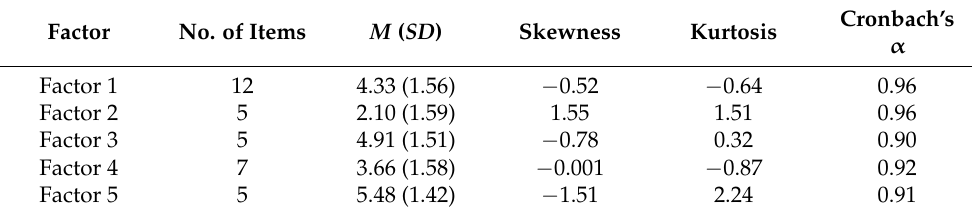
Table 3. Descriptive statistics from exploratory factor analysis of the five factors ( N =